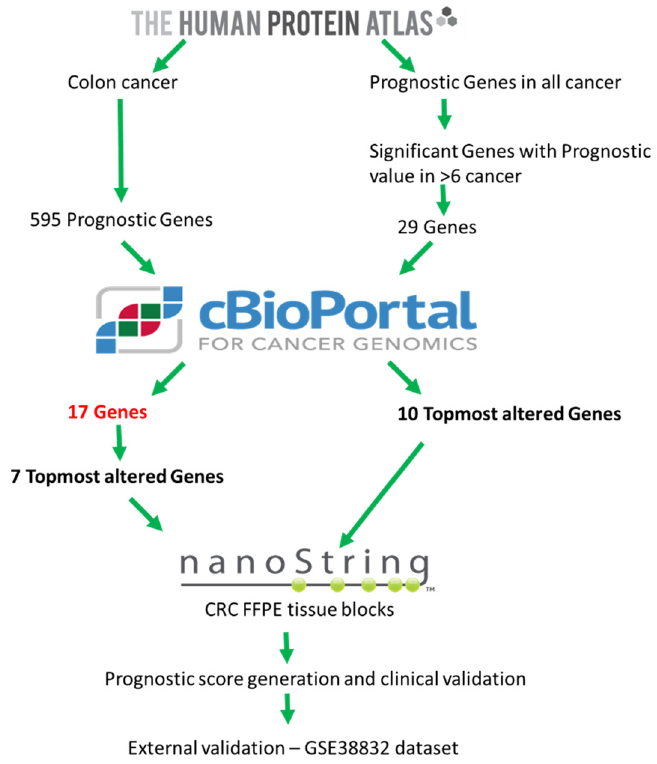
Figure 7. A flowchart depicting gene extraction methodology for generation of 17 gene panel.